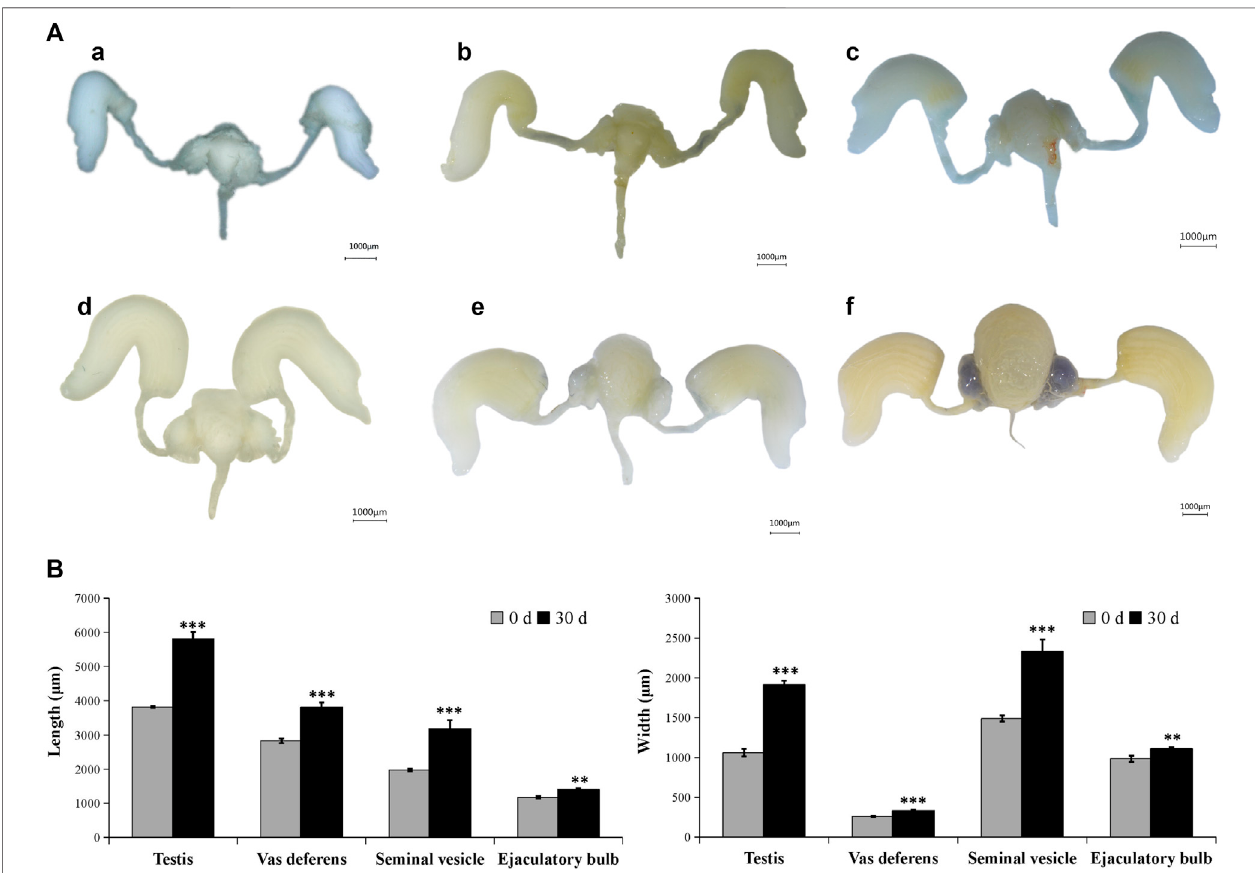
FIGURE2 | Development patternofmale reproductive system after JHIIIinjection. (A) Photographof male reproductive system at different day after JHIII injection. a, 0th day; b, 7th day; c, 14th day; d, 21st day; e, 28th day; f, 30th day. (B) Length and width of male reproductive structures (testis, vas deferens, seminal vesicle, ejaculatory bulb). **, p < 0.01; ***, p < 0.001 (independent t